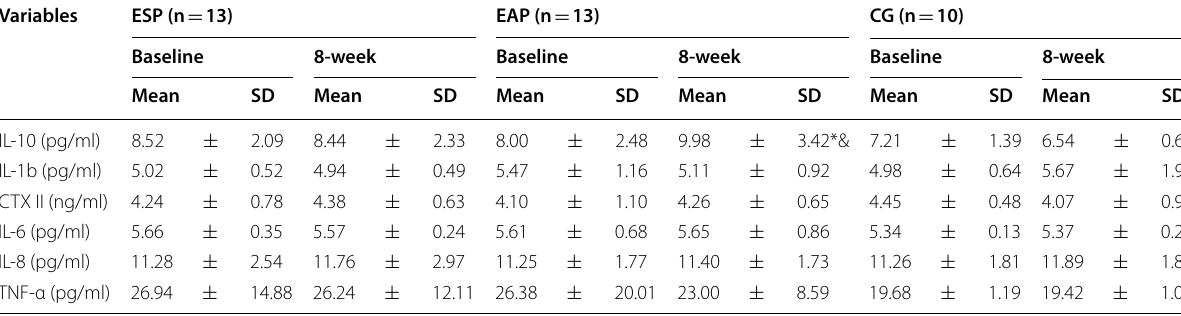
* statistical significance between in the baseline and 8-week values & statistical significance between in the 8-week values compare to CG group ESP: exercise and sham PBM group; EAP: exercise and active PBM group; CG: control